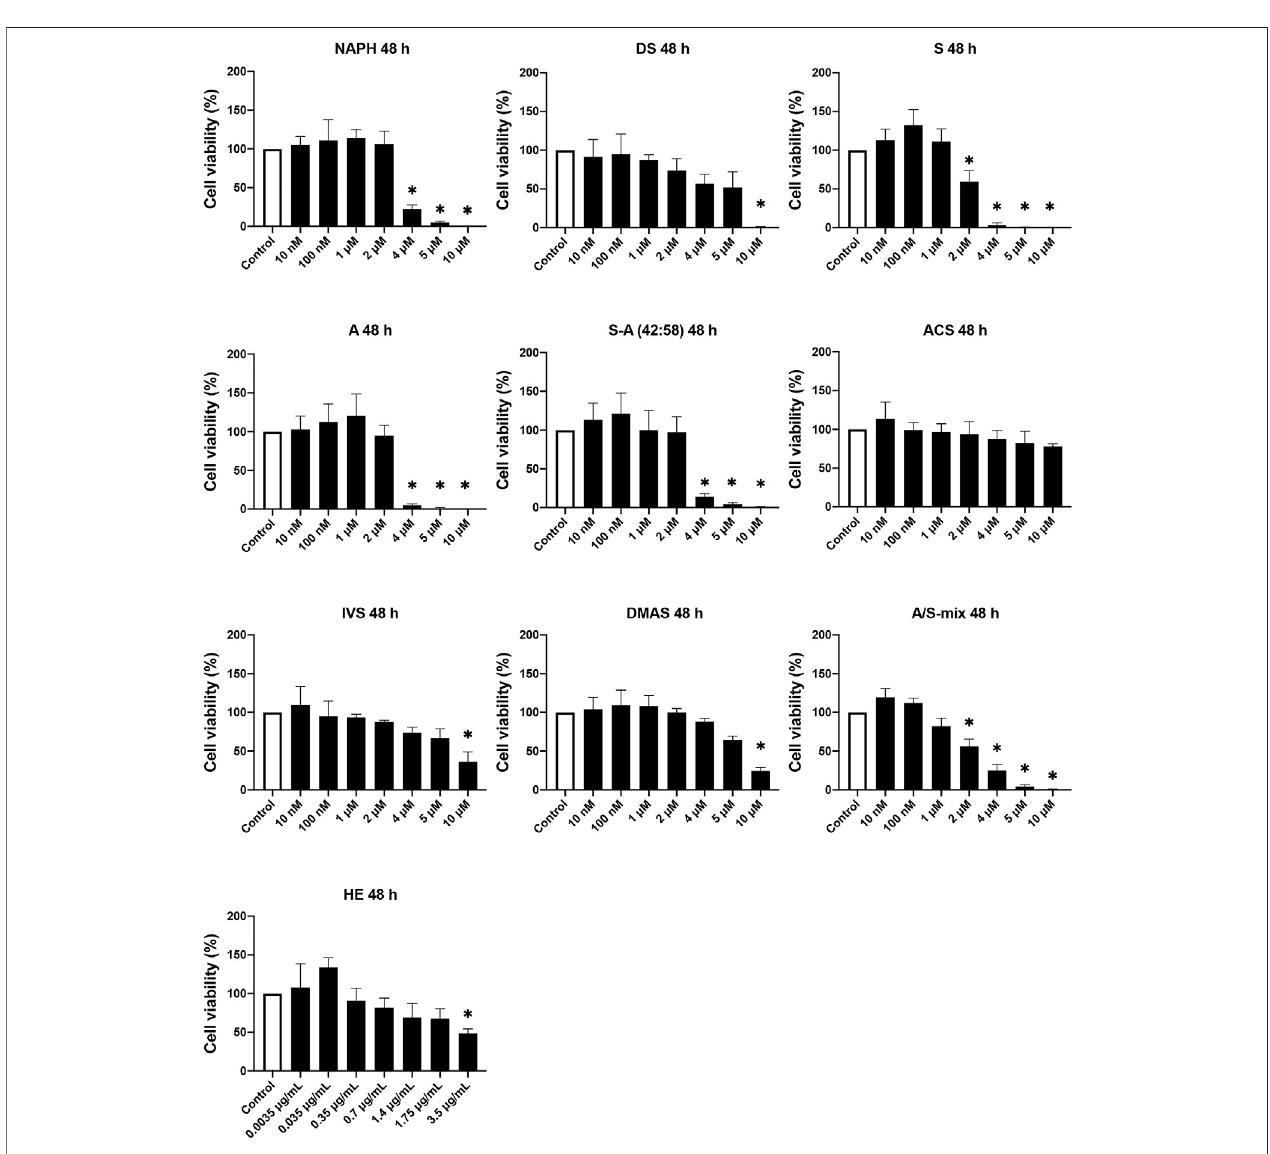
FIGURE2| Cellviabilityof3T3-L1pre-adipocytecellsupontreatmentwithvariousA/Sderivativesat48 h*indicates p < 0.05comparedtountreated(control)cells. Cell viability values are expressed as the percentage of viability observed in untreated cells (100% cell viability). Data are shown as the mean of three individual experiments